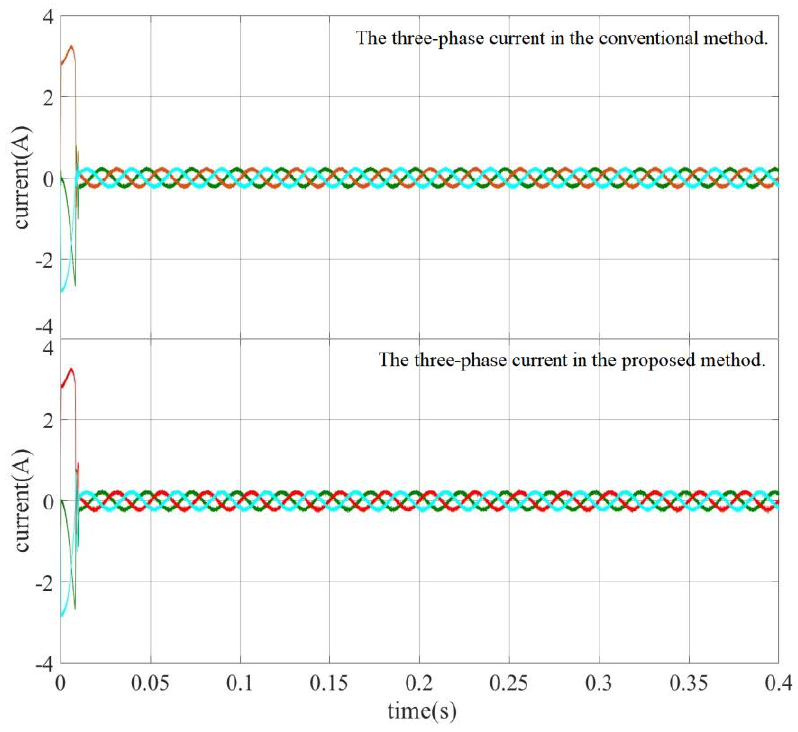
Figure 7. Three-phase current waveforms when the motor is in an approximately no-load state.